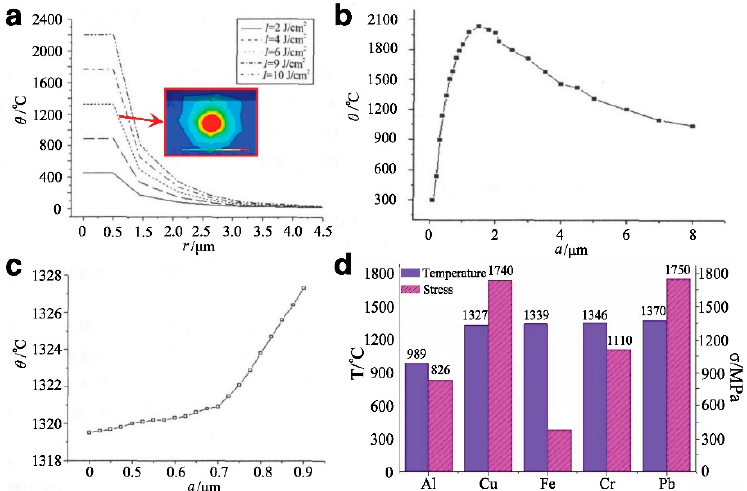
Figure 2. Effect of near surface impurities in KDP crystal on temperature and stress of materials. ( a ) Distribution of temperature field around impurities under laser irradiation with different energy densities. The enlarged view shows the three-dimensional temperature field at I = 6 J / cm 2 , a = 0.5 µ m; ( b )Temperature variation curve of impurity with its dimension; ( c ) Temperature variation curve from the center to the edge of Fe impurity; ( d ) The contract curve of maximum temperature and thermal stress of different types of impurities [35].